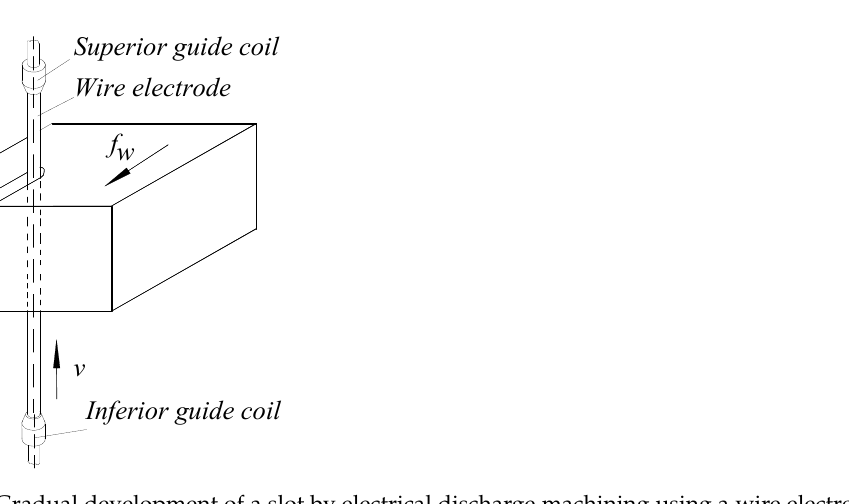
Figure 1. Gradual development of a slot by electrical discharge machining using a wire electrode supported in two guide coils.